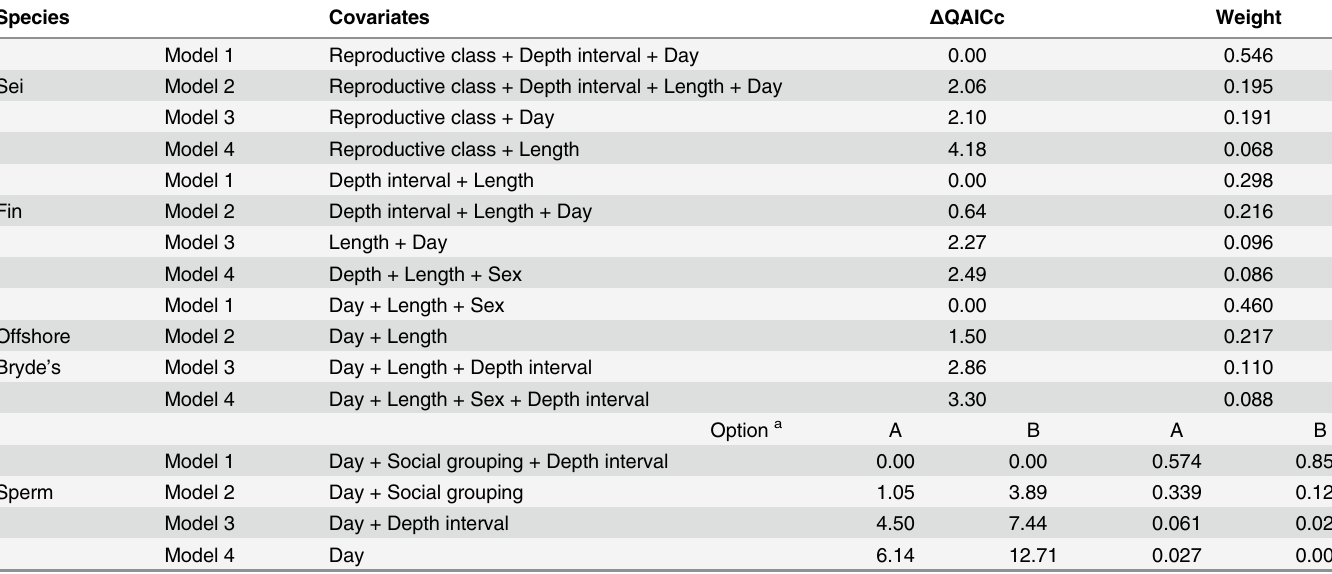
Table 3. Models for the total number of unhealed bites on all whale species, including differences in the QAICc scores ( Δ QAICc) and Akaike weights.